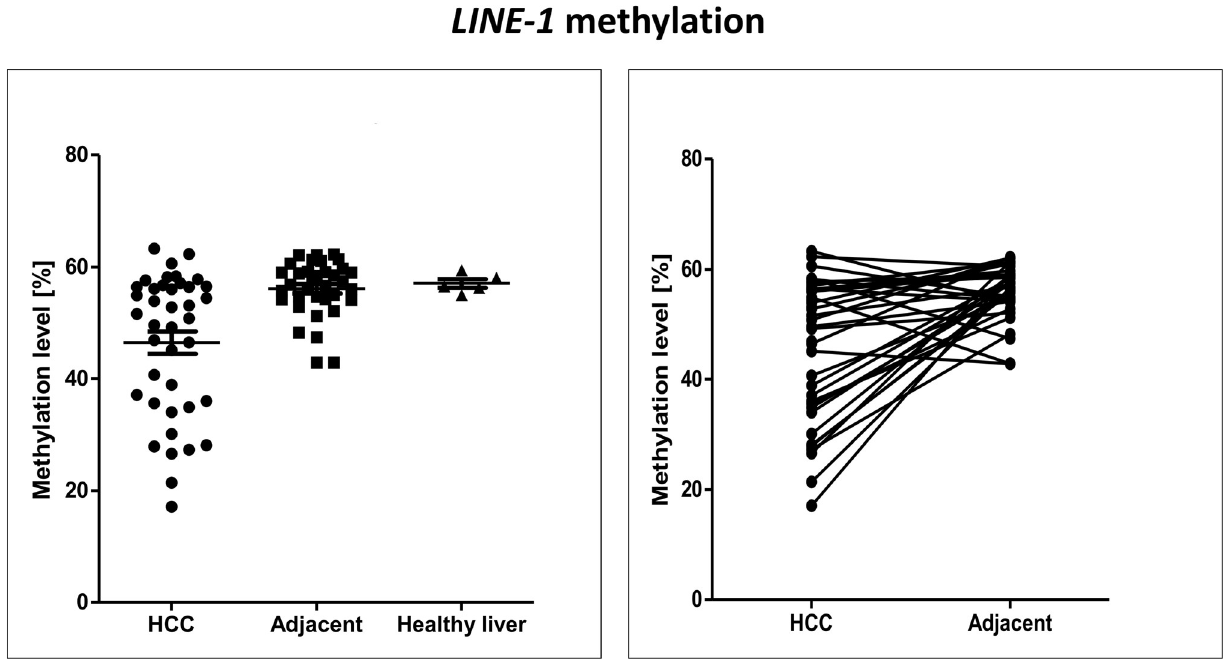
Fig 2. LINE-1 DNA methylation in HCC, adjacent peritumoral tissues, and healthy liver. Frequent loss of LINE-1 DNA methylation was observed in HCC primary tissues. Means of DNA methylation were 46.5, 56.1, and 57.1 in HCC, peritumoral, and healthy liver tissues respectively. LINE-1 DNA methylation levels were significantly lower in the HCC primary tissues compared to the adjacent peritumoral tissues and significant difference was not observed between peritumoral tissues and healthy liver tissues. For DNA methylation levels of individual CpG sites see S3 Table.